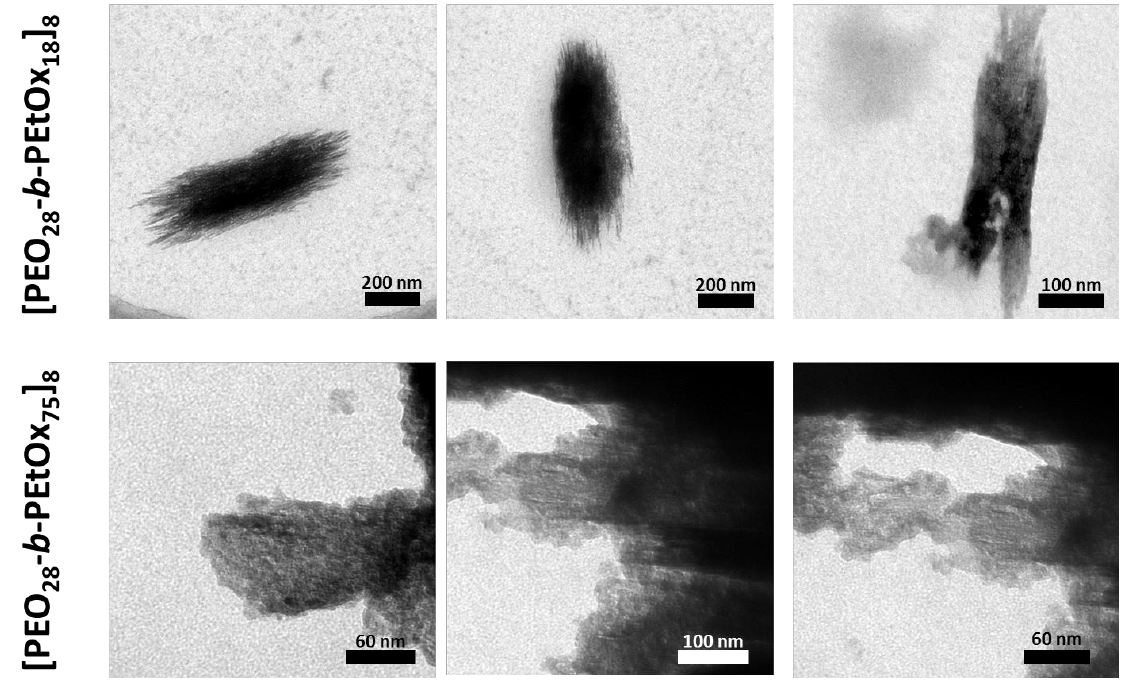
Figure 7. TEM micrographs of aggregates formed by [PEO [PEO - b -PEtOx ] ( bottom ) after heating for three days at 80 °C (unfiltered solutions, 28 75 8 “arm-first”